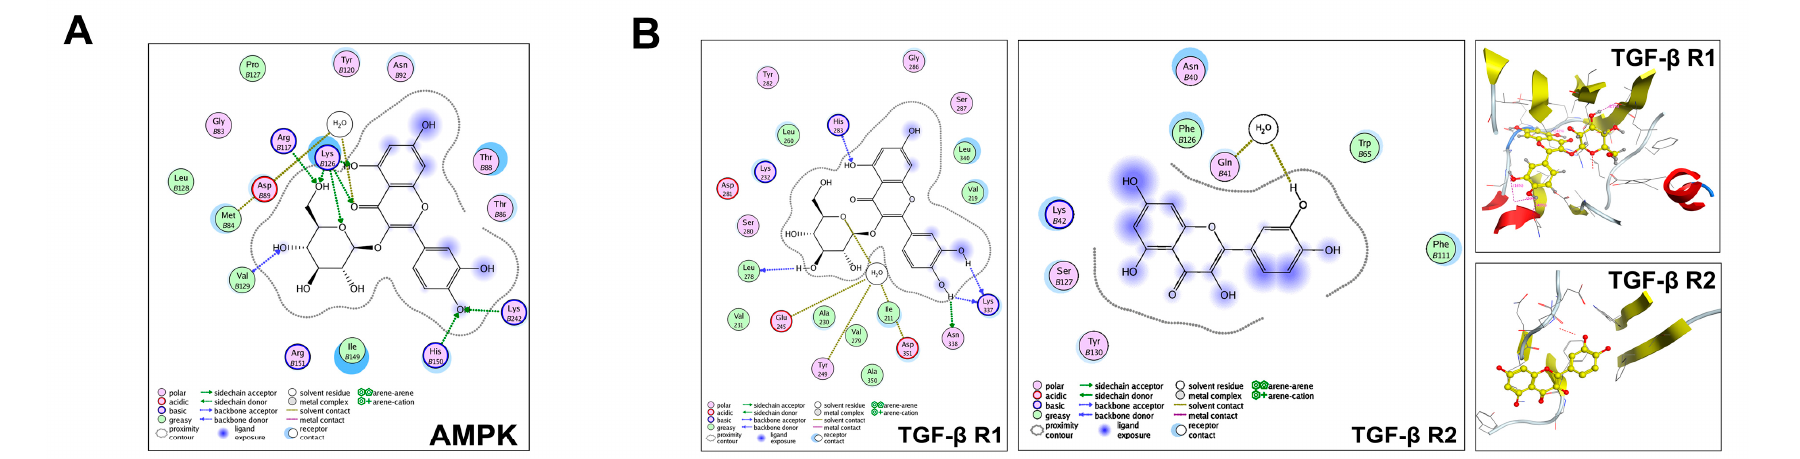
Figure 5. Predict the potential mechanism of IQ. ( A ) Docking results of IQ with AMPK. Amino acid residues which are thought to interact with IQ are shown in 2D representation using LigX in MOE (PDB number: 2YA3); ( B ) docking results of IQ with the TGF- β receptor, TGF- β R1 (access code: 1VJY.pdb), and TGF- β R2 (access code: 1KTZ.pdb) Amino acid residues, which are thought to interact with IQ are shown in two-dimensional (2D) representation using LigX in MOE. Hydrogen bonding is shown in dotted lines along with percentages.